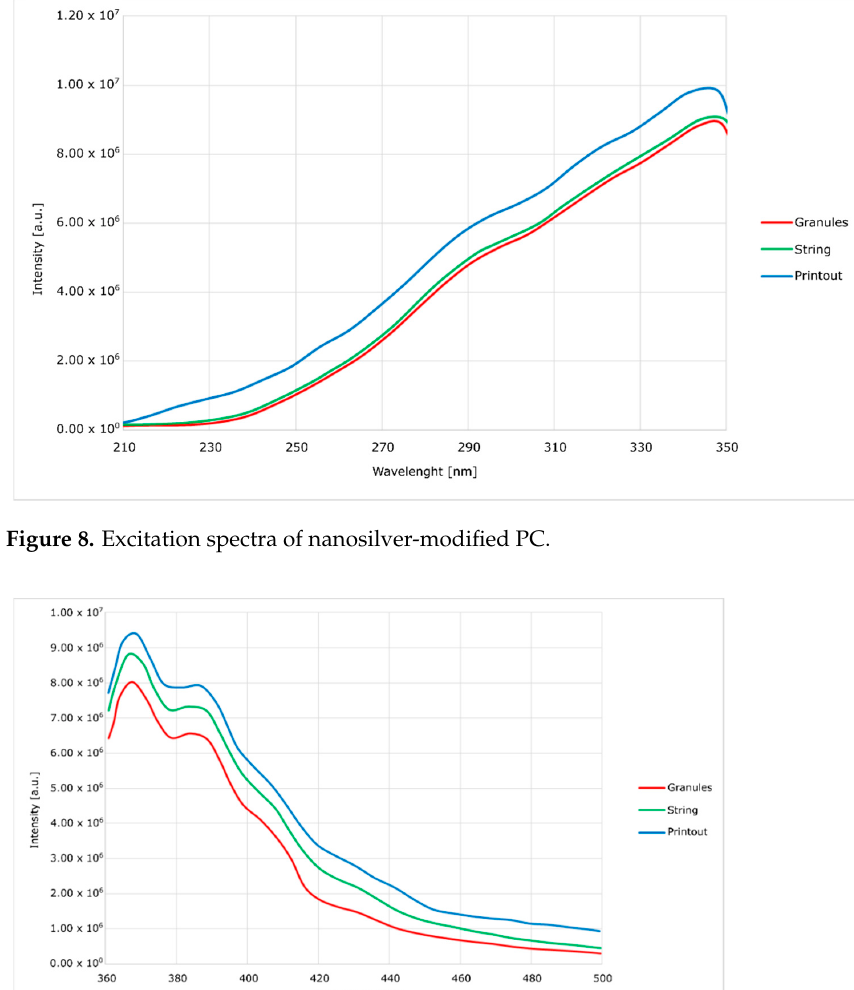
Figure 9. Emission spectra of nanosilver-modified PC .